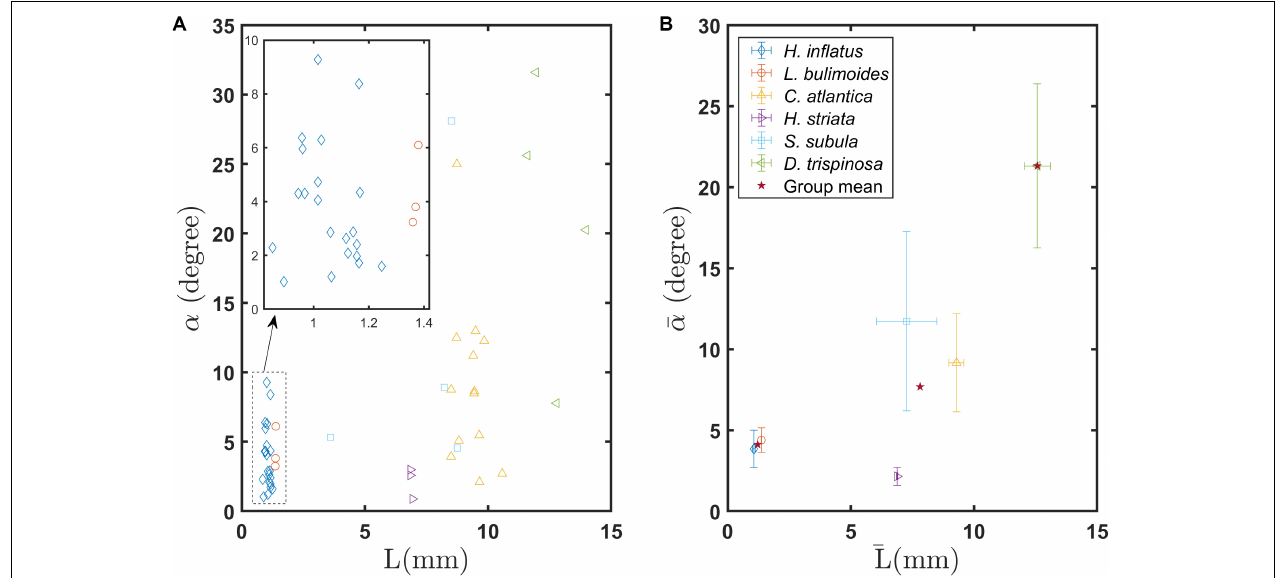
FIGURE 8 | (A) Gliding angle of individual marine snails as a function of body length L, (B) Mean gliding angles of various marine snail species as a function of mean body length ¯ L . Stars in (B) indicate group means of coiled, elongated, and globular shelled thecosome species.